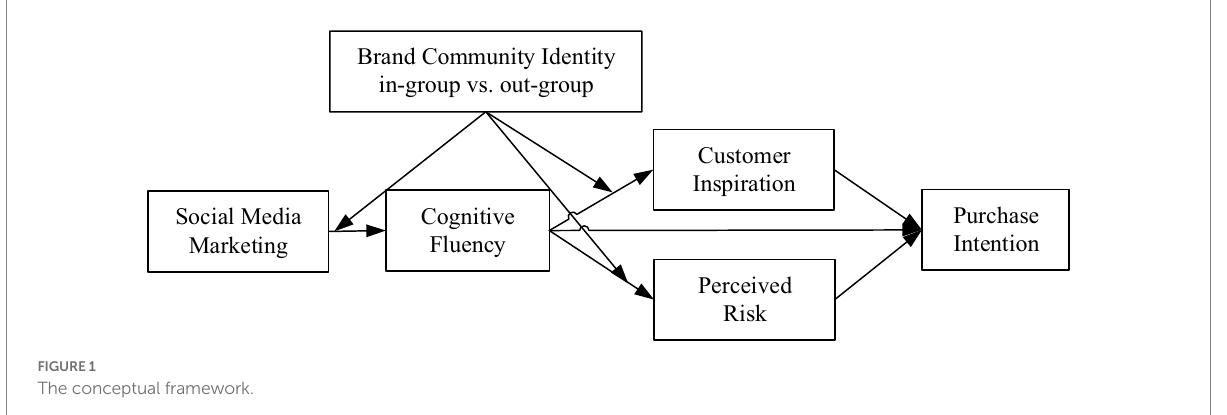
FIGURE 1 The conceptual